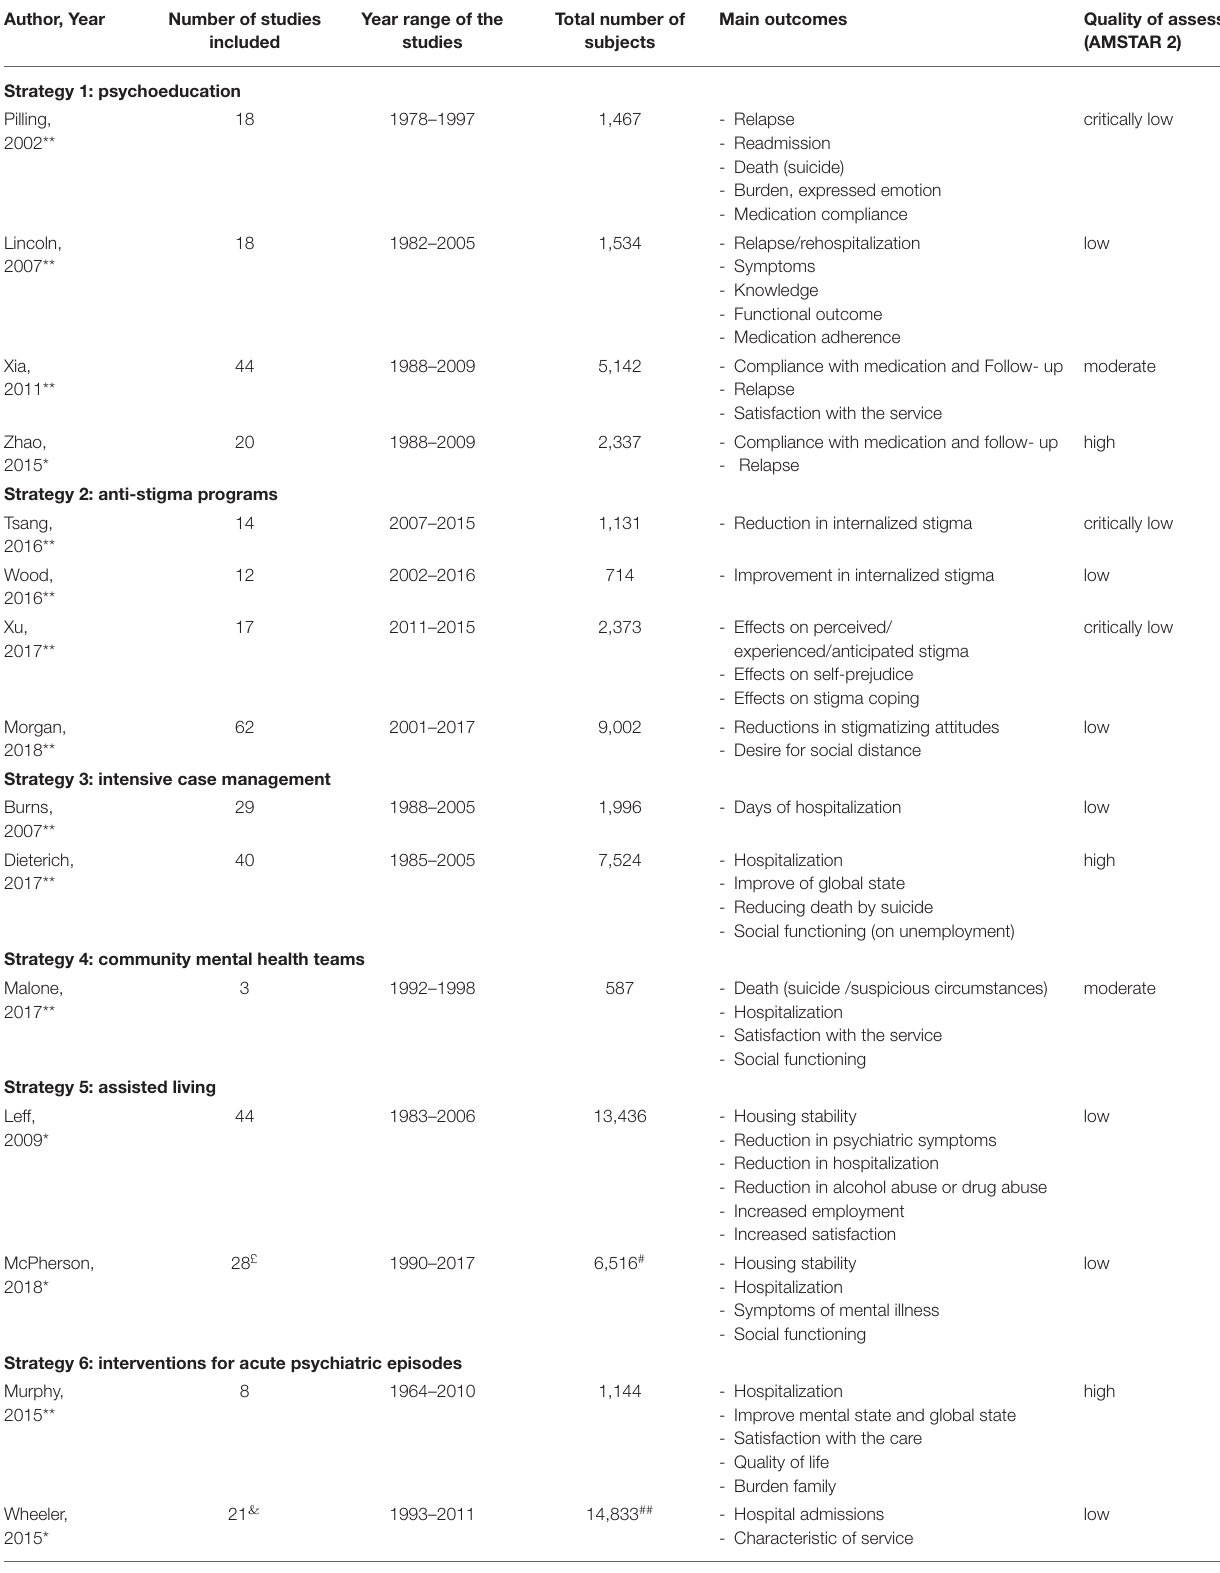
TABLE 1 | Characteristics of the included systematic